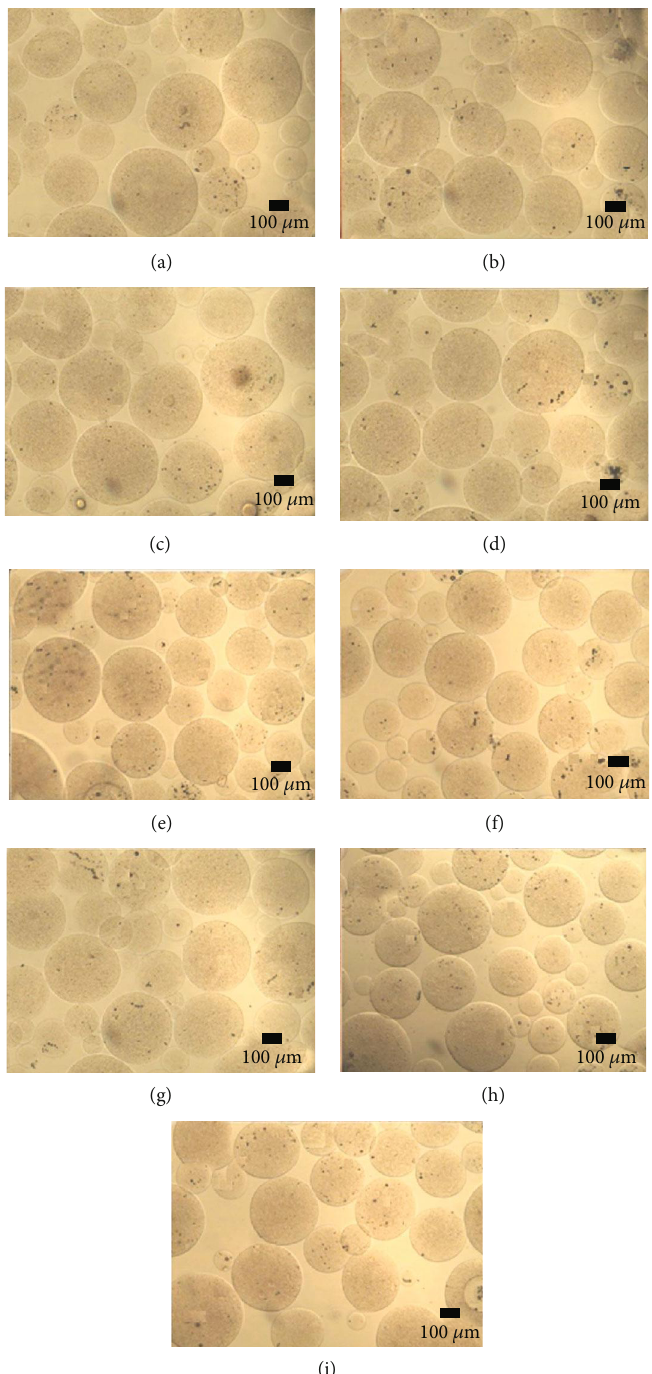
Figure 20: Optical micrographs of alginate microcapsules produced with di ff erent procedures, diameter, span factor, and mechanical strength